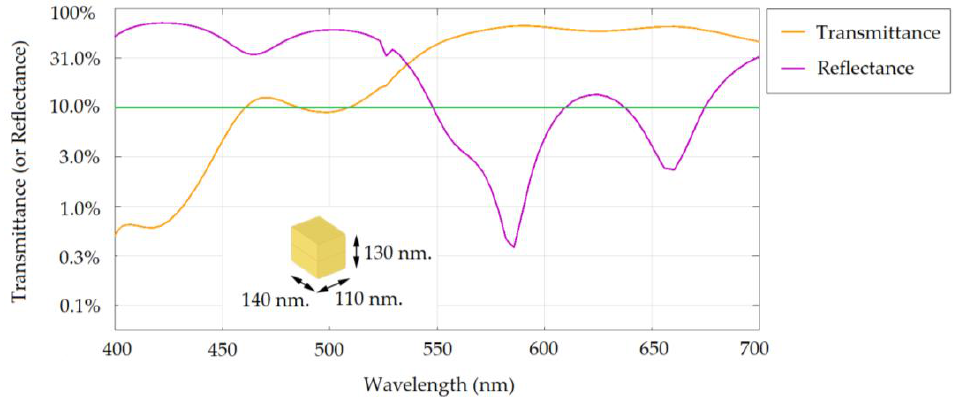
Figure 7. Transmittance when H is varied from 130 to 200 nm.